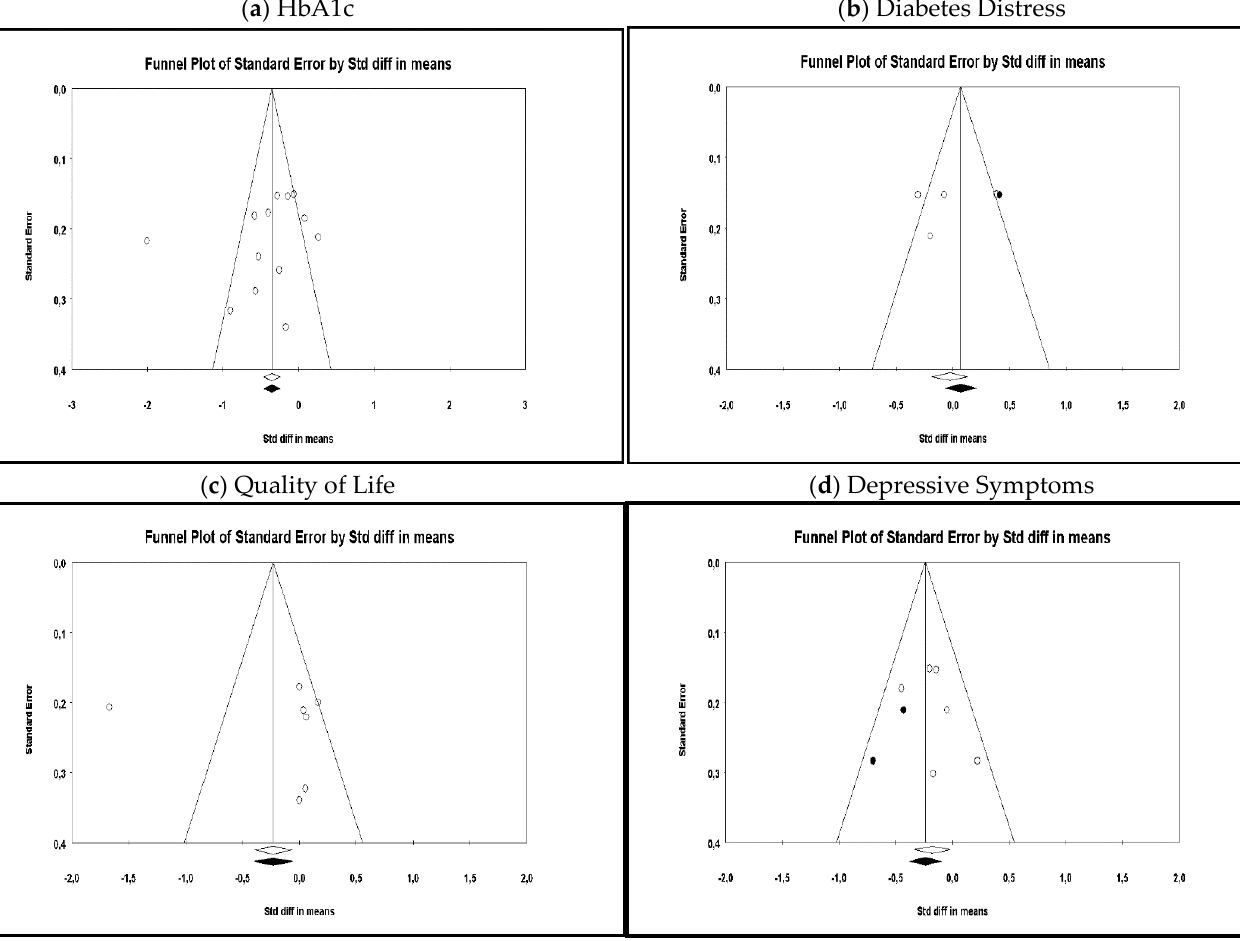
Figure 5. Publication bias Funnel Plots (observed and imputed). Note. Each dot represents a single RCT; Y-axis = the standard error (RCTs with lower power are shown at the bottom, those with higher power at the top of the funnel); X-axis = the SMD; an asymmetrical dots distribution suggest bias.